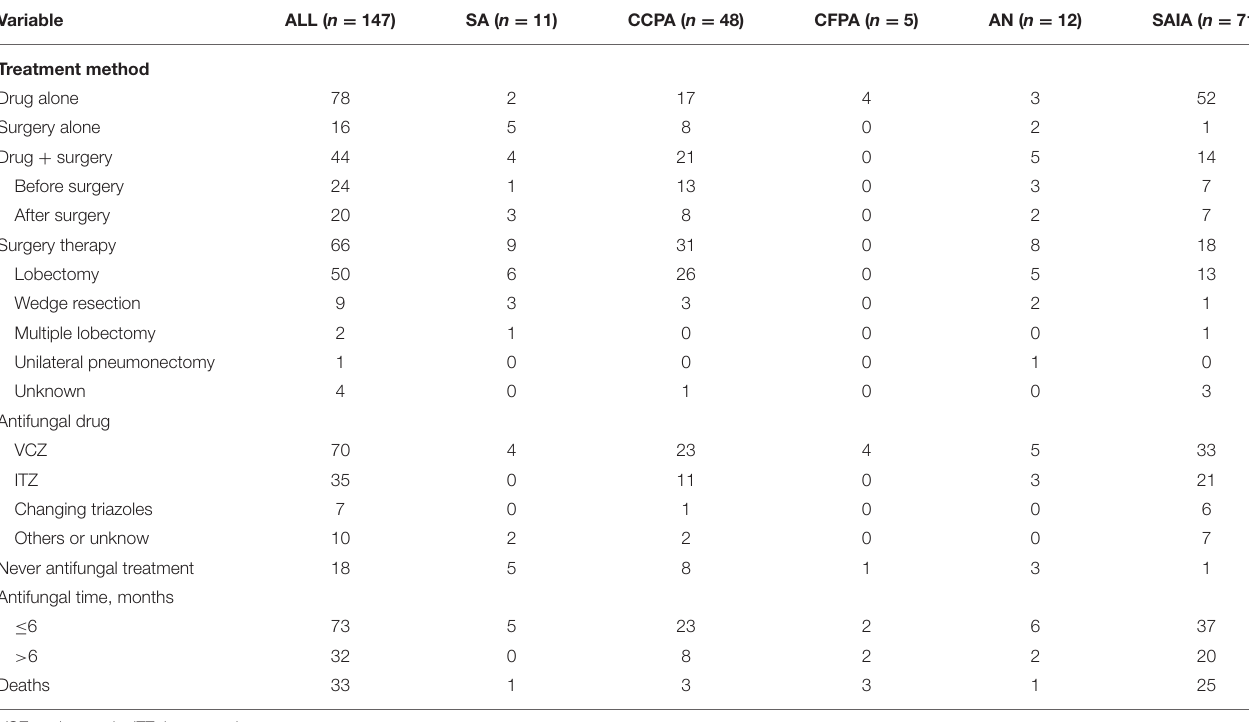
TABLE 4 | Treatment and outcomes of patients with CPA in different subtypes. Variable